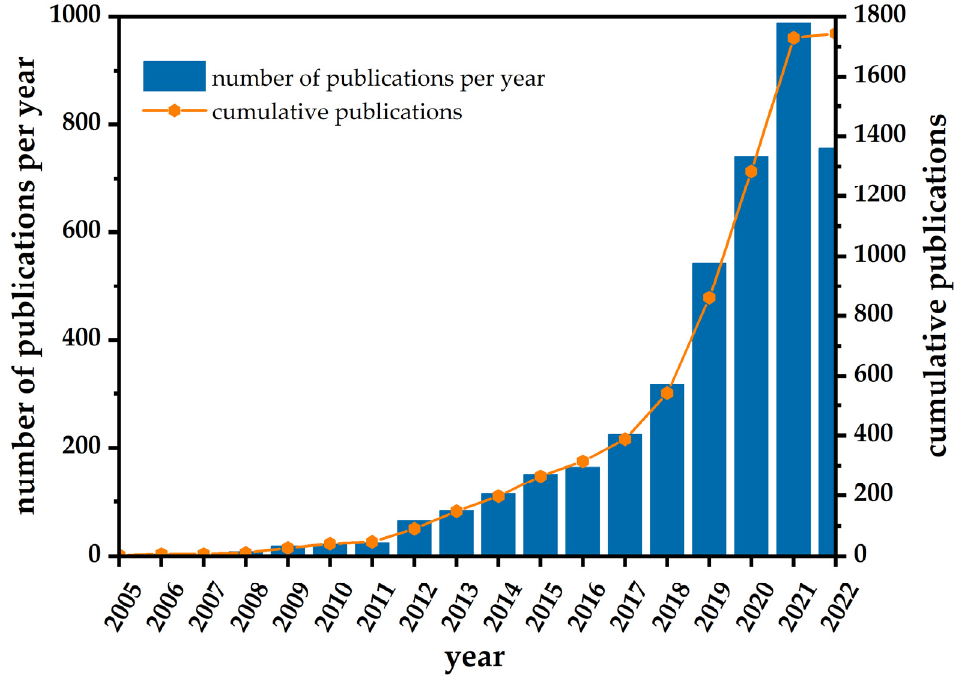
Figure 1. Number of publications per year and cumulative publications regarding nanosilver-based electrochemical sensors for environmental analysis.